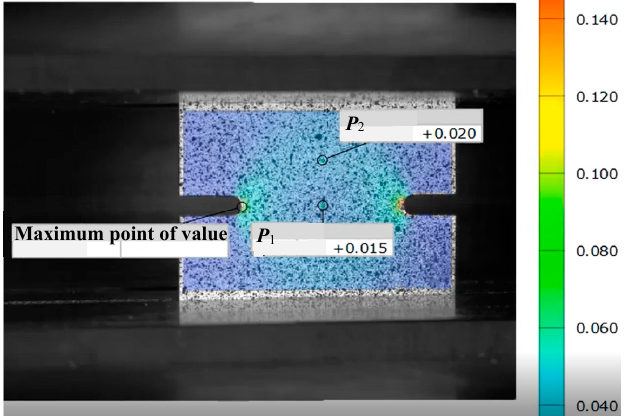
Figure 7. Maximum principal strain distribution.